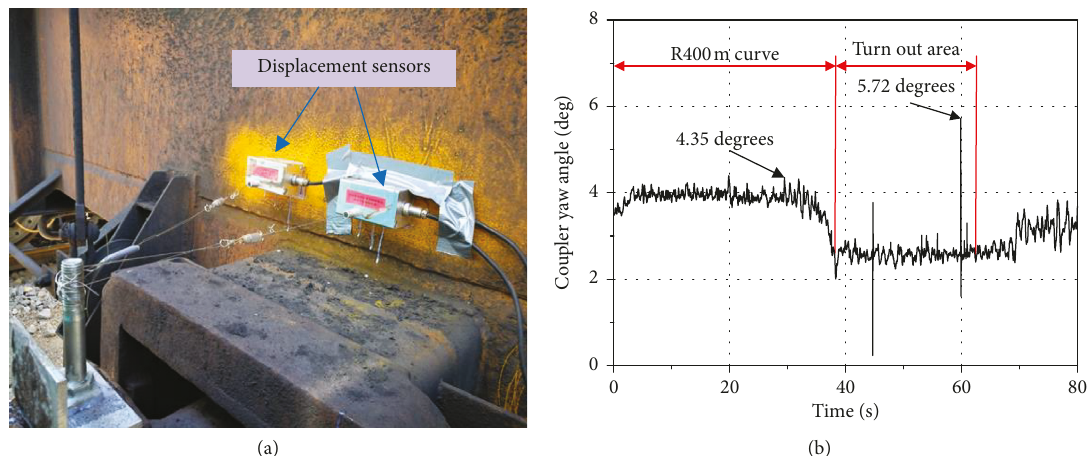
Figure 13: Measurements of coupler yaw angle: (a) displacement sensors for measuring the coupler yaw angle; (b) the measured coupler yaw angle.